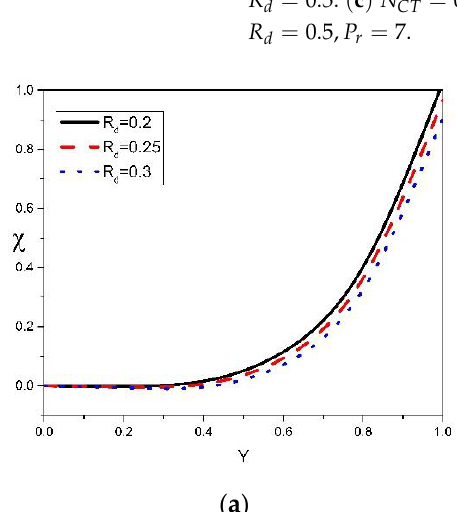
R d = 0.5. ( c ) N CT = 0.7, N TC = 0.7, R d = 0.5, N t = 0.5, P r = 7, ( d ) N CT = 0.7, N TC = 0.7, N b = 0.5,